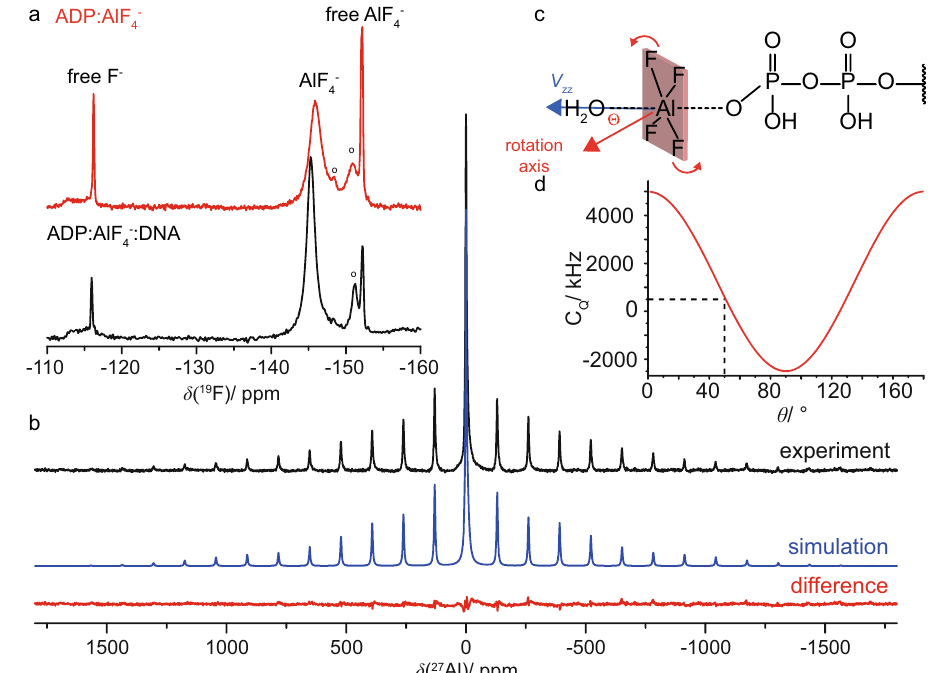
Fig. 5 The AlF 4 − species bound to DnaB is rotating. a 19 F MAS-NMR spectra recorded at 14.0 T with a MAS frequency of 17.0 kHz and with the EASY background suppression scheme 108 . Spectra were acquired on DnaB:ADP:AlF 4 − in the presence and absence of DNA; “ o ” indicates